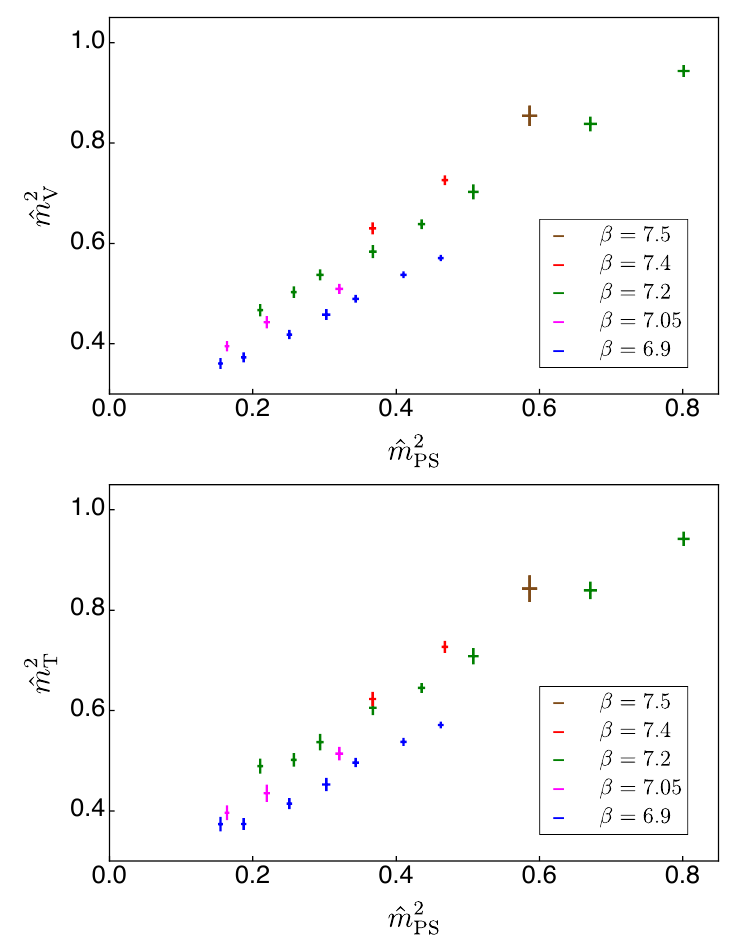
Figure 8. Mass squared of mesons sourced by vector (V, top) and tensor (T, bottom) operators as a function of the pseudoscalar mass squared ^ m 2 . Di(cid:11)erent colours refer to di(cid:11)erent lattice PS couplings as shown in the legends. The error bars represent the size of statistical uncertainties. (See appendix A.3 for the